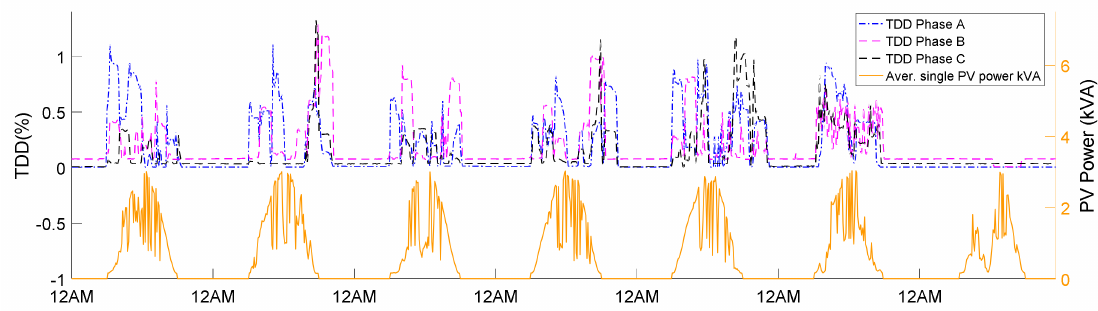
Figure 10. Total demand distortion (TDD) during one week with PV